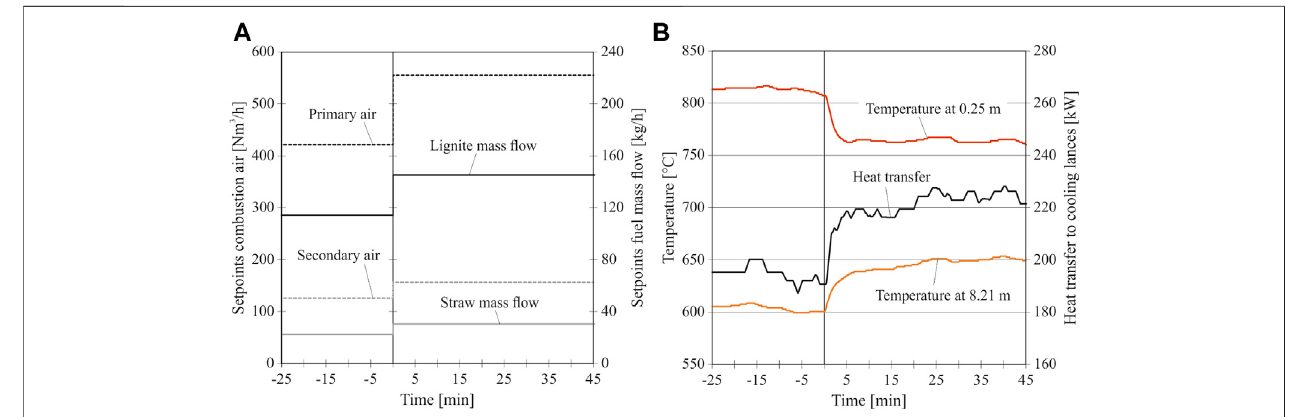
FIGURE 3 | Experimental procedure: Load change from 436 to 568 kW load (lignite and straw co-combustion). (A) Step input (B) Step response.